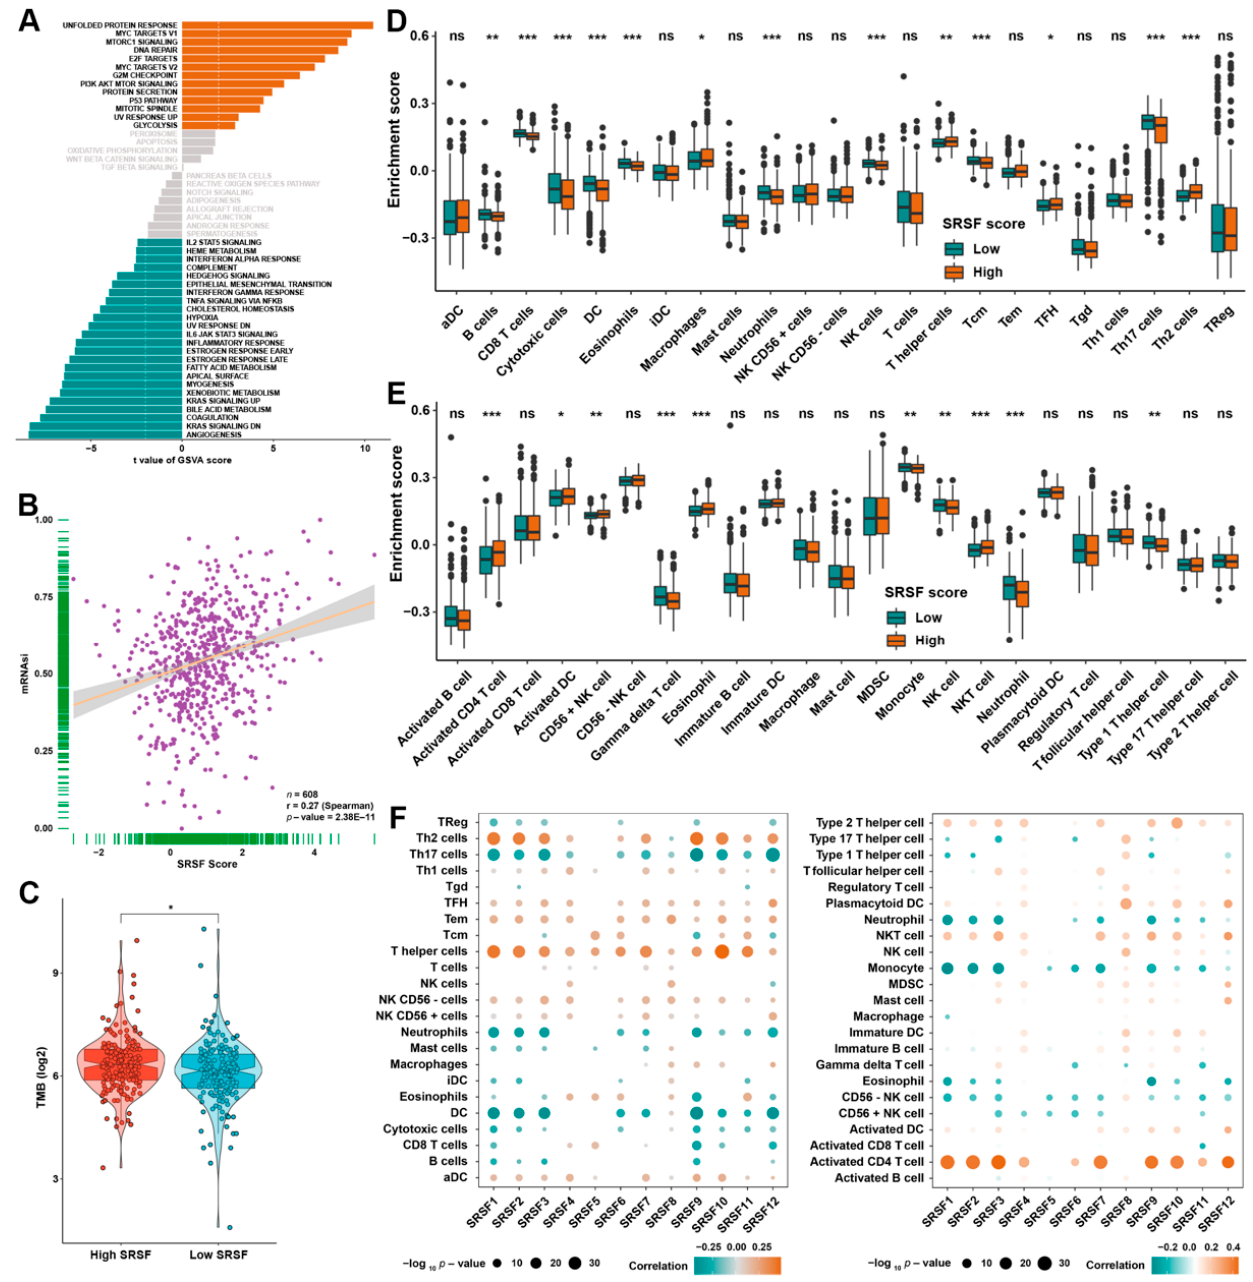
Figure 6. The biological features of HCC patients with various SRSF scores in the TCGA cohort. ( A ) GSVA showed the enriched signaling pathways in patients with different SRSF scores in the aggregated HCC cohort. ( B ) Correlation analysis between the SRSF score and the mRNAsi index. ( C ) TMB score in the SRSF high- or low-score groups of the TCGA cohort. ( D , E ) The diversity of immune cell infiltration patterns between patients with various SRSF scores is displayed. ( F ) Correlation analysis between SRSF family genes and infiltrating immune cells. The size of the circle represents the P value, with red representing a positive correlation and green representing a negative correlation. The asterisks represent the statistical p -value (* p < 0.05, ** p < 0.01 and *** p < 0.001. ns, no significance).